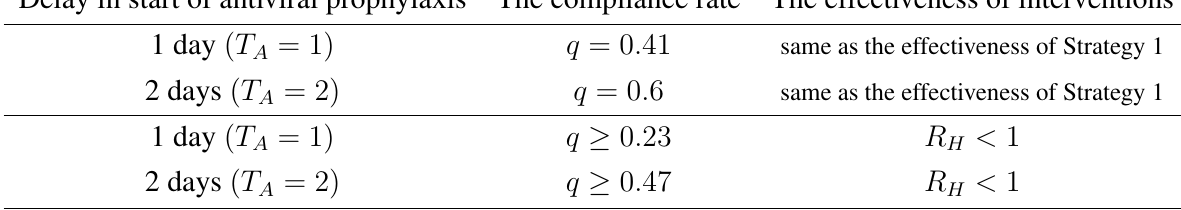
Table 2. The needed compliance rates to achieve the same level of effectiveness as < 1 . Strategy 1 or R H